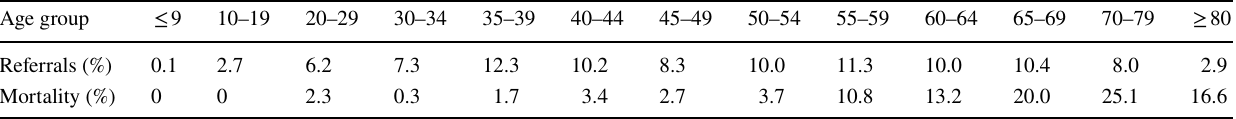
Table 2 Age groups of patients admitted to the Petroleum Hospital between March 2020 to March 2021